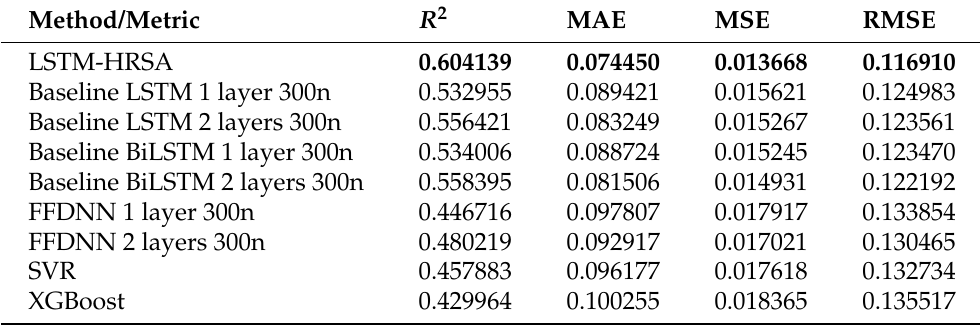
Table 9. The results of the best-produced model compared to the traditional ML methods and baseline LSTM and BiLSTM. The best result in each column is written in